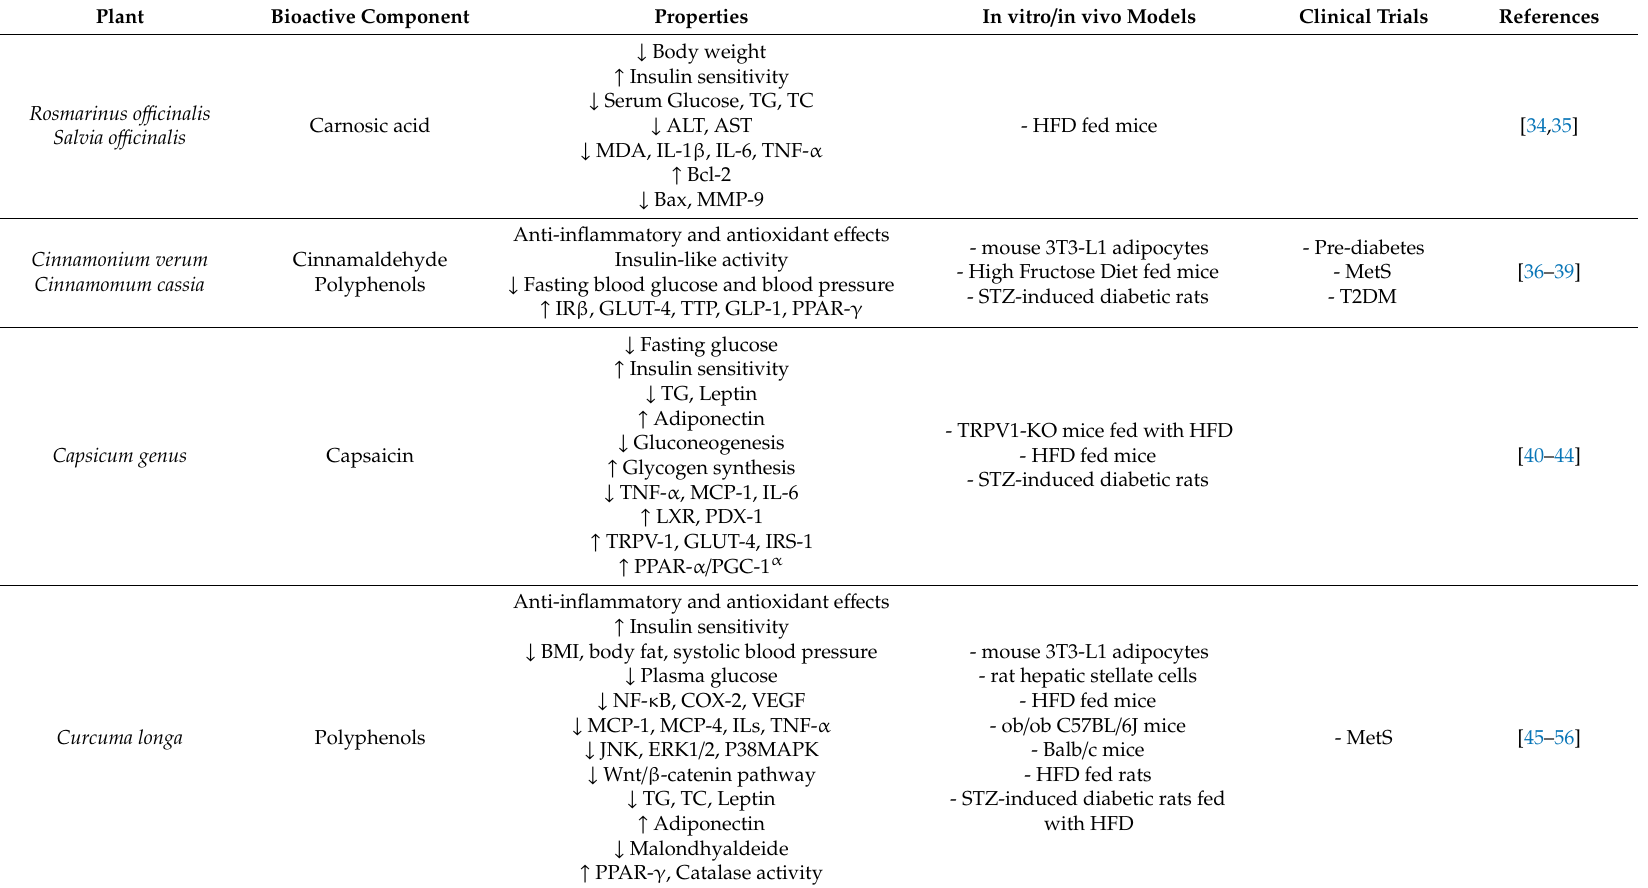
Table 2. The main properties of di ff erent natural